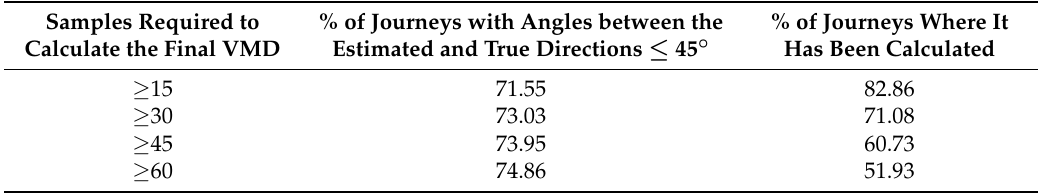
Table 3. VMD results using raw accelerometers removing